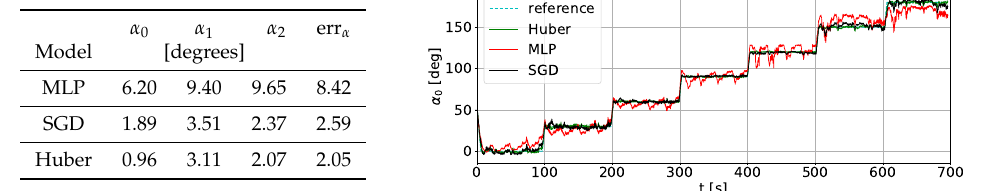
Figure 7. A comparison of accuracies for considered regressors with a different kernel transformation (thanks to [40]): MLP (tanh kernel with linear output layer, using MSE criterion), SGD (RBF kernels with the Nyström method with SGDRegressor using MSE criterion), Huber (RBF kernels with the Nyström method kernel with robust Huber linear